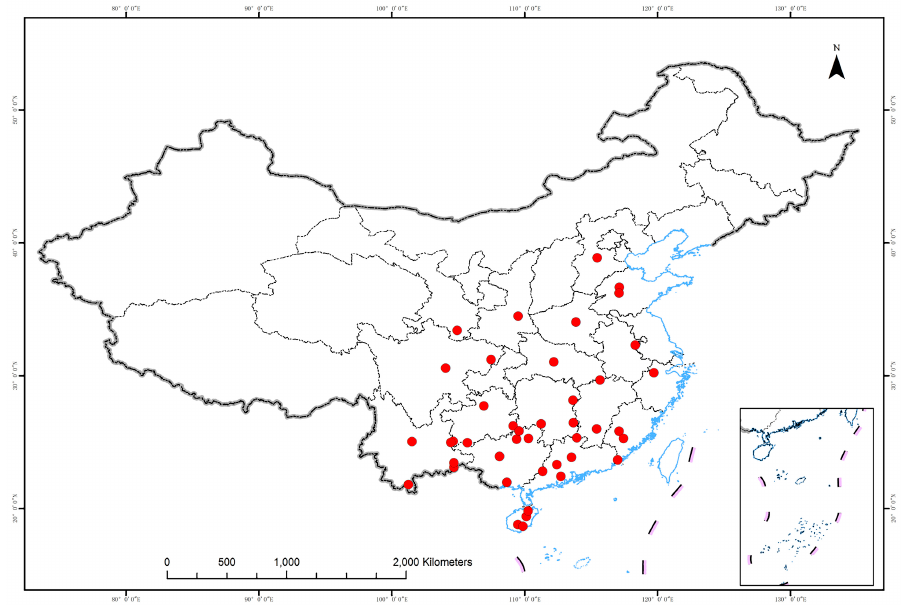
Figure 1. Geographic locations of the populations sampled in this study. Table 1. Population information for this study.